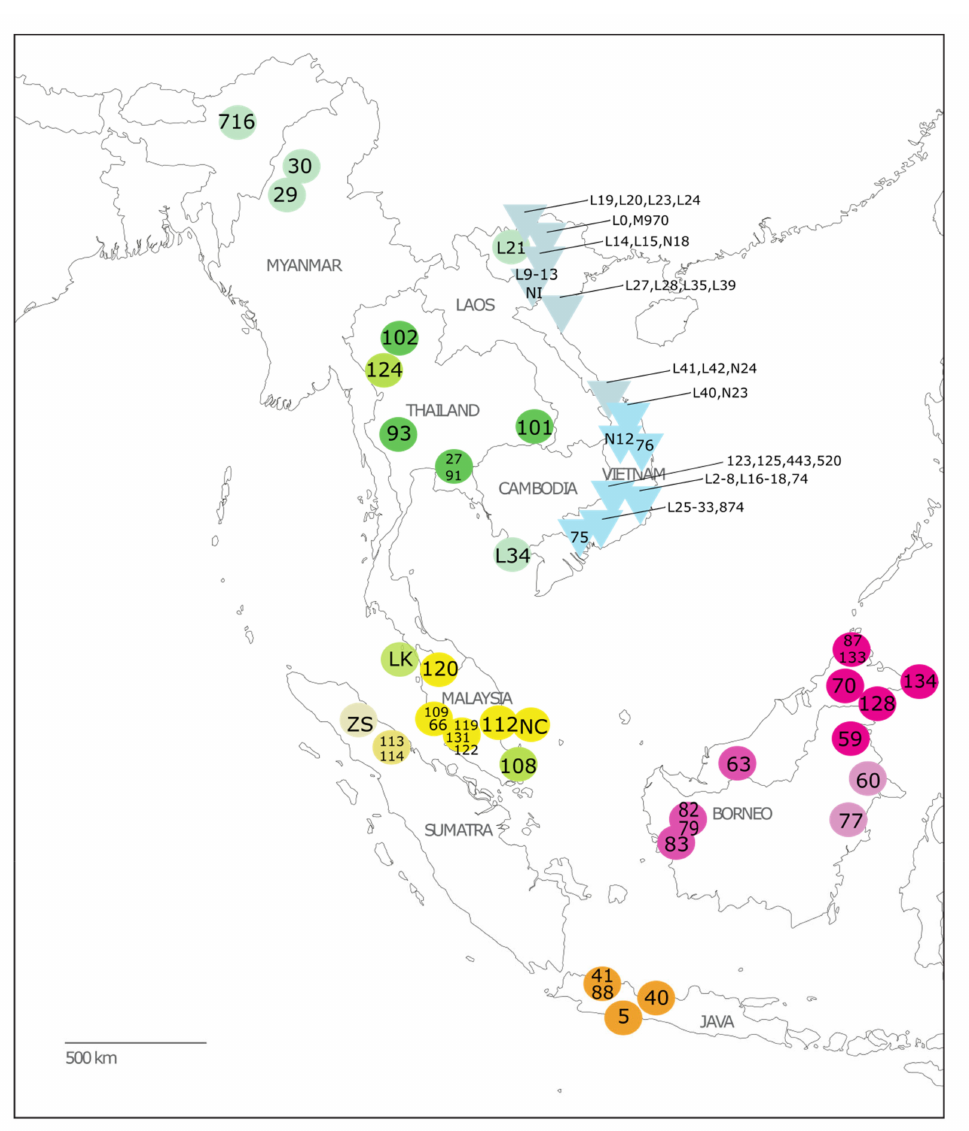
Figure 1. Geographic coverage of the samples included in this study for which provenance is known. Triangles represent pygmy loris samples, and circles represent slow loris samples. Colors represent clades, as shown in Figure 2. Sample IDs correspond to details provided in Tables 1 and